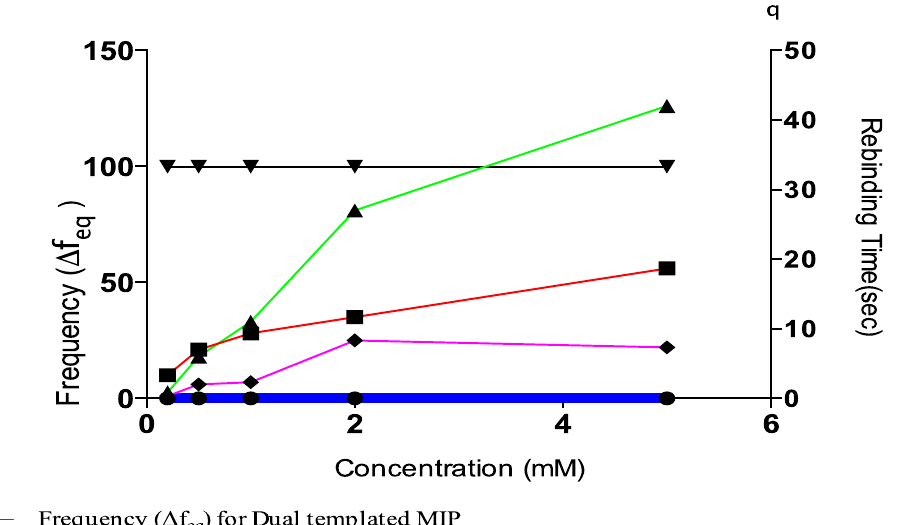
Figure 1. Comparative plot of concentration, rebinding time and frequency.